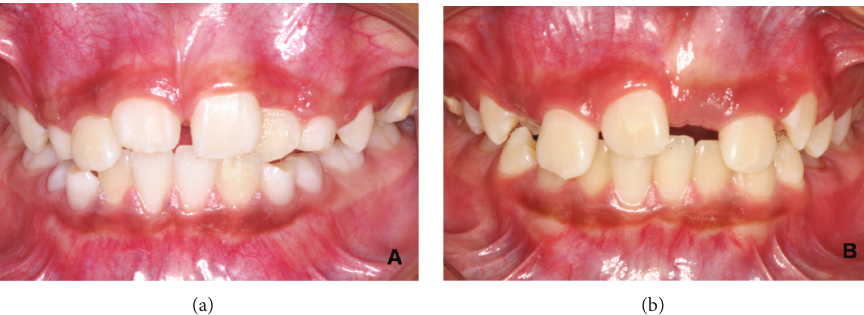
Figure 7: Intraoral view showing the permanent maxillary central incisors erupted in twin A and the permanent maxillary central right incisor erupted in twin